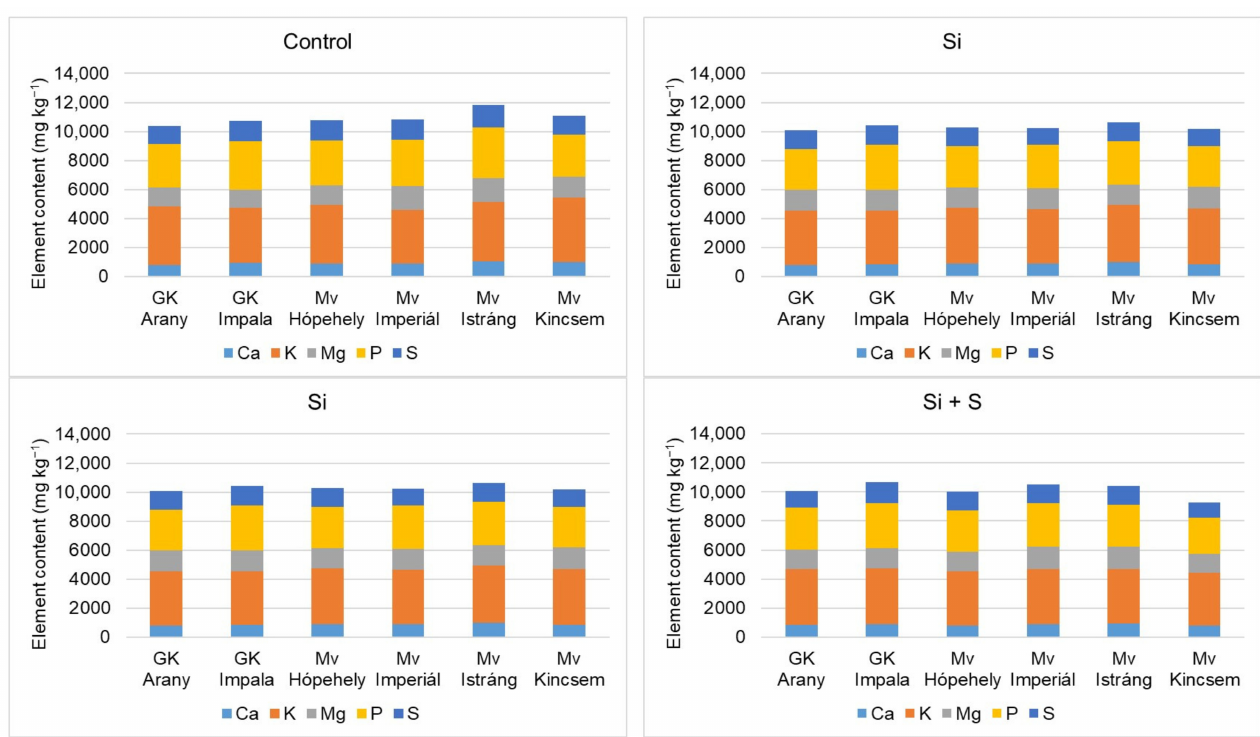
Figure 9. Whole grain Ca, K, Mg, P, and S contents of the winter oat varieties as a function of the foliar fertilisation treatments.